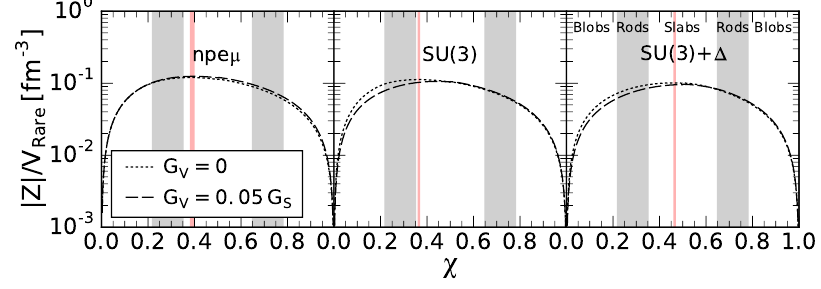
Figure 4. Charge number per unit volume of the rare phase structures for the DD2 parametrization [7]. See Figure 2 for additional details. Similar figures for the SWL, GM1L, and ME2 parametrizations can be found in Reference